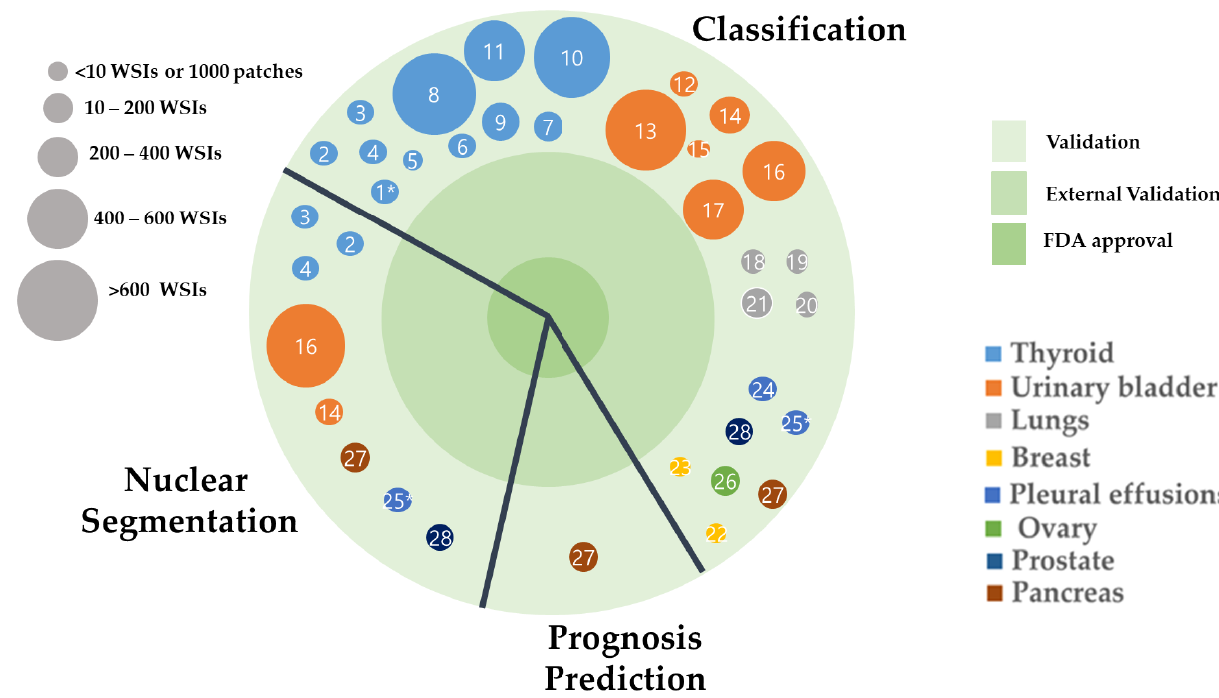
Figure 8. The application of AI models using cytological images applied for tumor classification, prognosis prediction, and nuclear segmentation. Published studies are denoted by serial numbers in Table 1. The studies are stratified according to the level of supporting evidence (outer circle, internally validated; middle circle, externally validated; inner circle, FDA-approved). * Indicates the dataset was in nuclei form instead of patches.